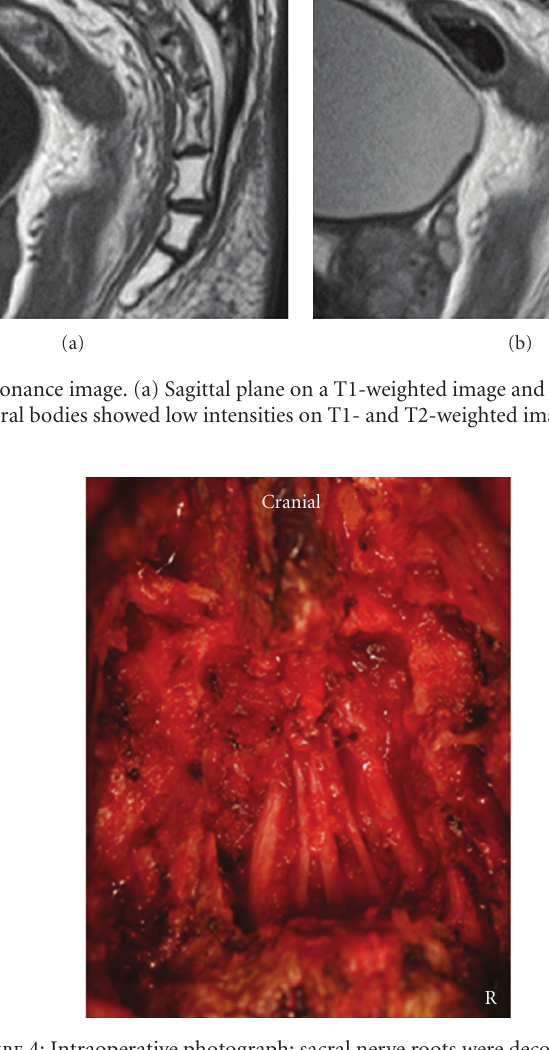
Figure 4: Intraoperative photograph: sacral nerve roots were